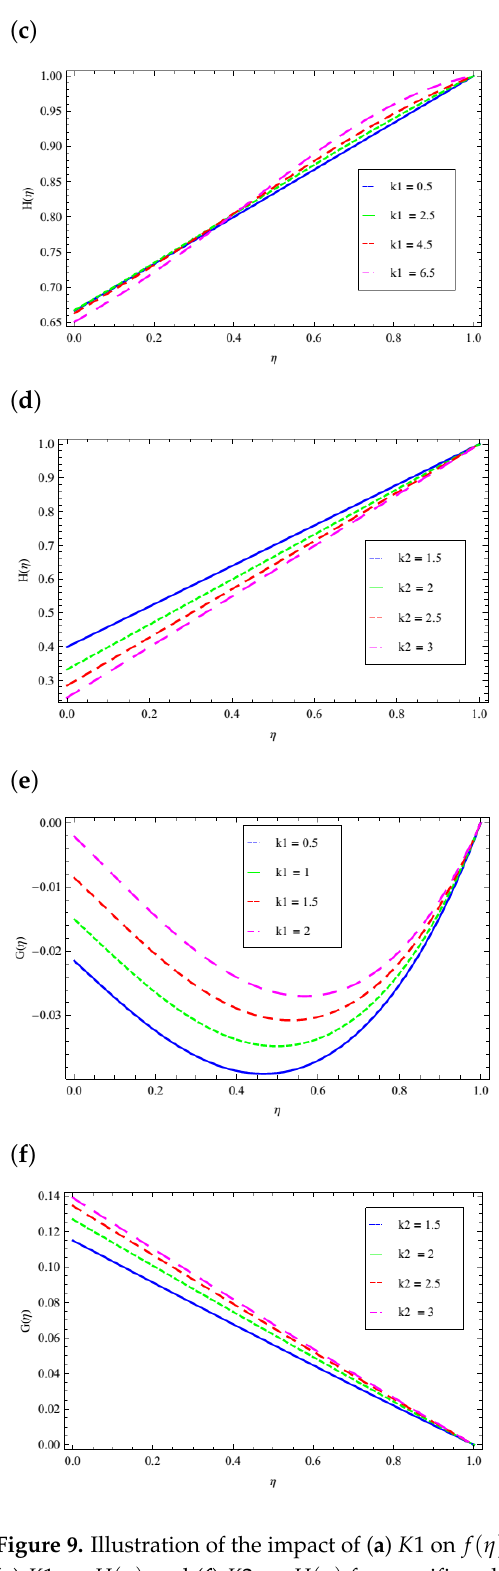
Figure 9. Illustration of the impact of ( a ) K 1 on f ( η ) , ( b ) K 2 on f ( η ) , ( c ) K 1 on G ( η ) , ( d ) K 2 on G ( η ) , ( e ) K 1 on H ( η ) and ( f ) K 2 on H ( η ) for specific values S = − 2, P r = Sc = 1, R = 0.5, = Ha = 0.1, L = 2, δ = 5, Q =